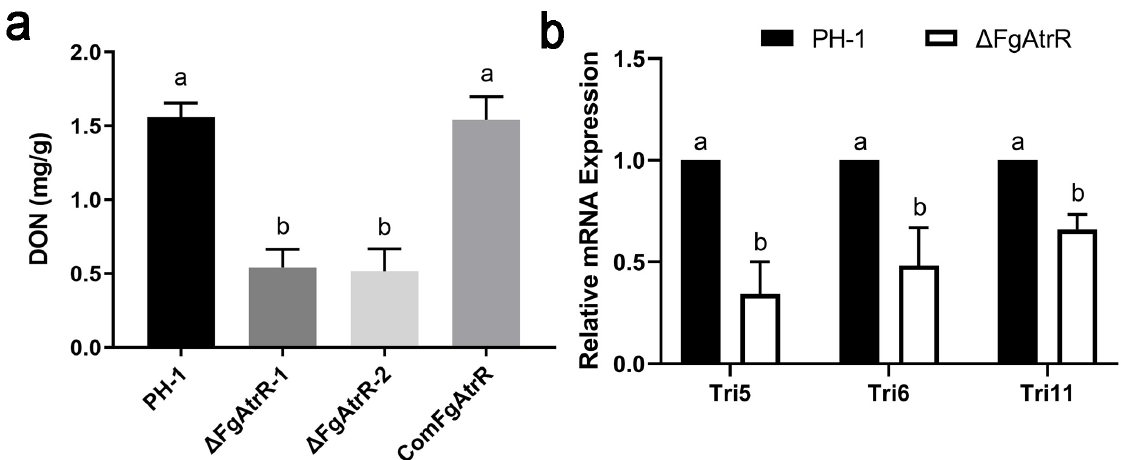
Figure 4. FgAtrR is vital for deoxynivalenol (DON) biosynthesis in Fusarium graminearum . ( a ) DON production level (per gram of dried mycelia) of each strain in TBI medium was measured. Error bars denote standard errors of three independent experiments. ( b ) Relative expression levels of DON biosynthesis-related genes TRI5 , TRI6 , and TRI11 in each strain. The actin gene was used as the internal control, and the expression level of each gene in PH-1 was arbitrarily set to 1. The means of bars followed by different letters are significantly different at the p < 0.05 level.